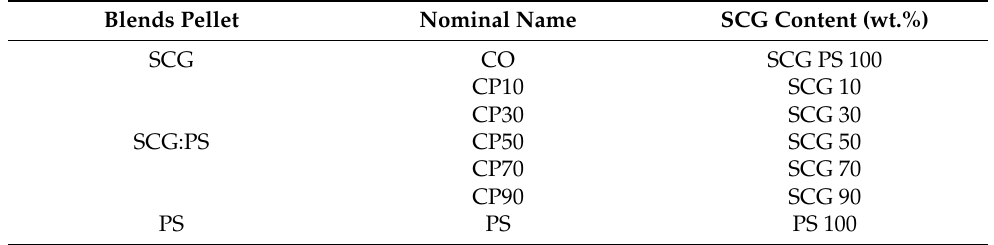
Table 2. Names and spent coffee grounds (SCG) contents of the samples used in the experiment.